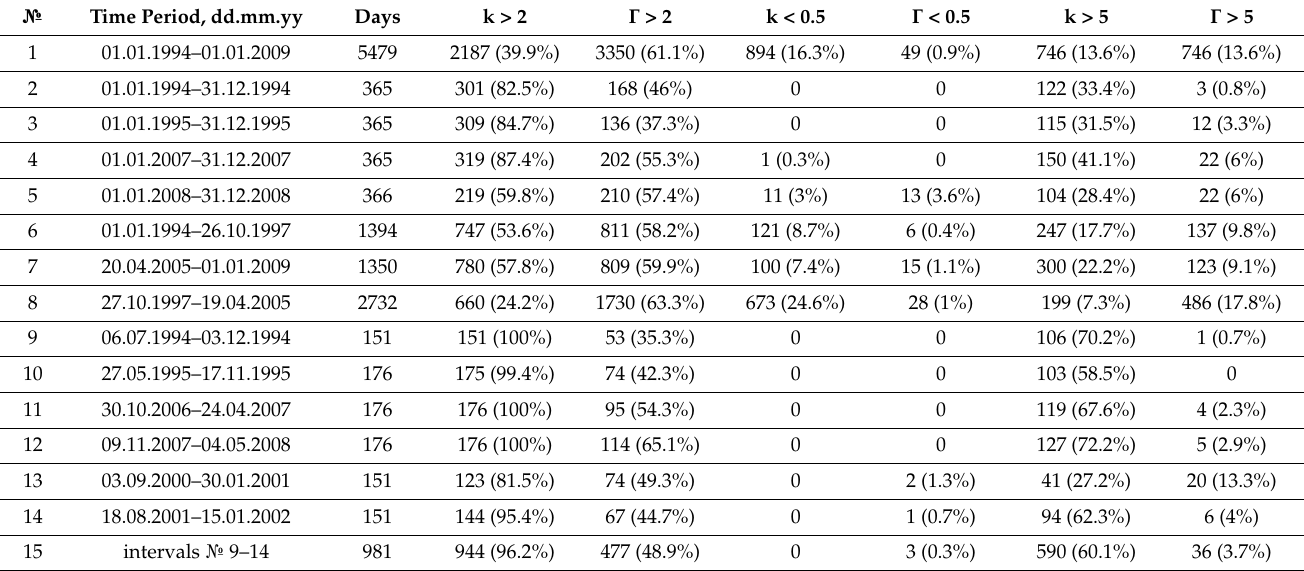
Table 1. Cases of large and small values of the parameters k and Γ for various time intervals .